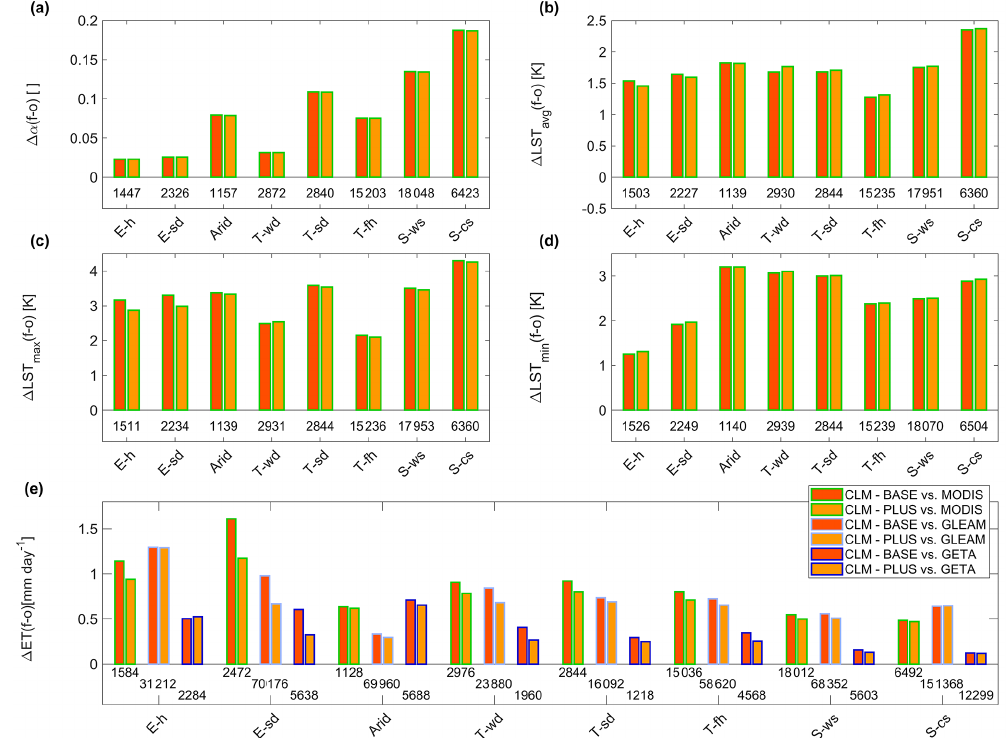
Figure 4. RMSD of CLM-BASE (red) and CLM-PLUS (orange) against MODIS observations over Köppen–Geiger climate zones (Kottek et al., 2006, Fig. 1) of monthly (a) (cid:49)α(f − o) , (b) (cid:49) LST avg (f − o) , (c) (cid:49) LST max (f − o) , and (d) (cid:49) LST min (f − o) . Panel (e) shows the RMSD over the Köppen–Geiger climate zones of (cid:49) ET (f − o) of CLM-BASE (red), and CLM-PLUS (orange) against MODIS (green edge), GLEAM (light blue edge), and GETA (dark blue edge). The numbers indicate the size of the data samples used for the calculation of RMSD. Table 1. ET and latent heat flux in situ observations from various studies and the values in CLM-BASE and CLM-PLUS at the